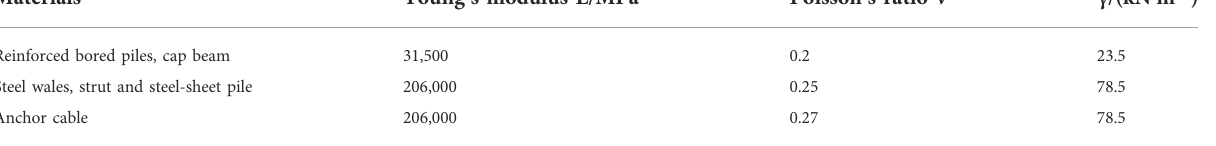
TABLE 3 Mechanical parameters of retaining structures in the numerical